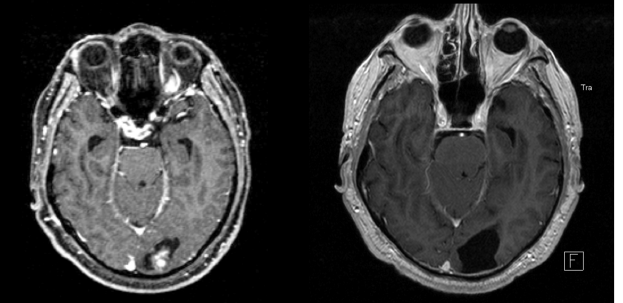
Figure 4. Cumulative incidence of bleeding events per metastasis, stratified by pretreatment intracranial hemorrhage (ICH).